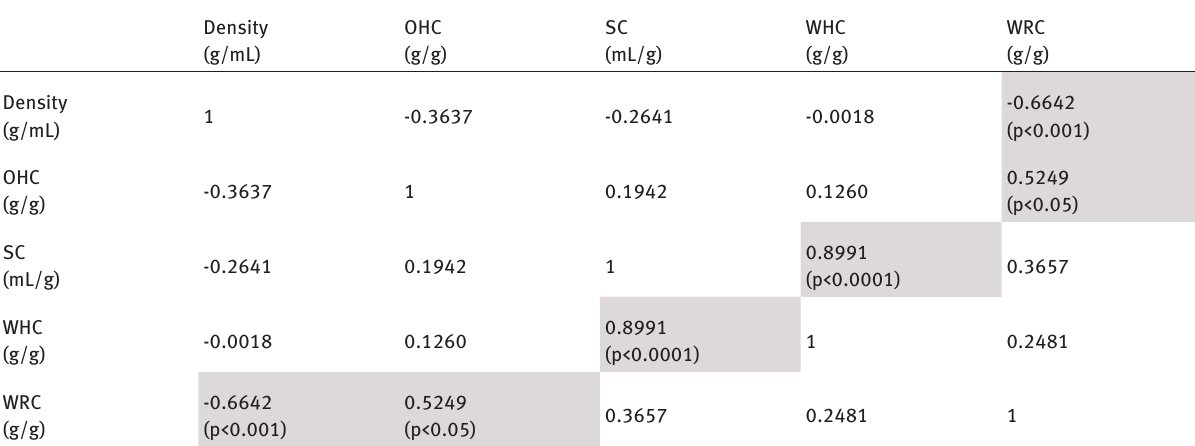
Table 5: Pearson product moment coefficients between variables for peach DF obtained with convective air drying